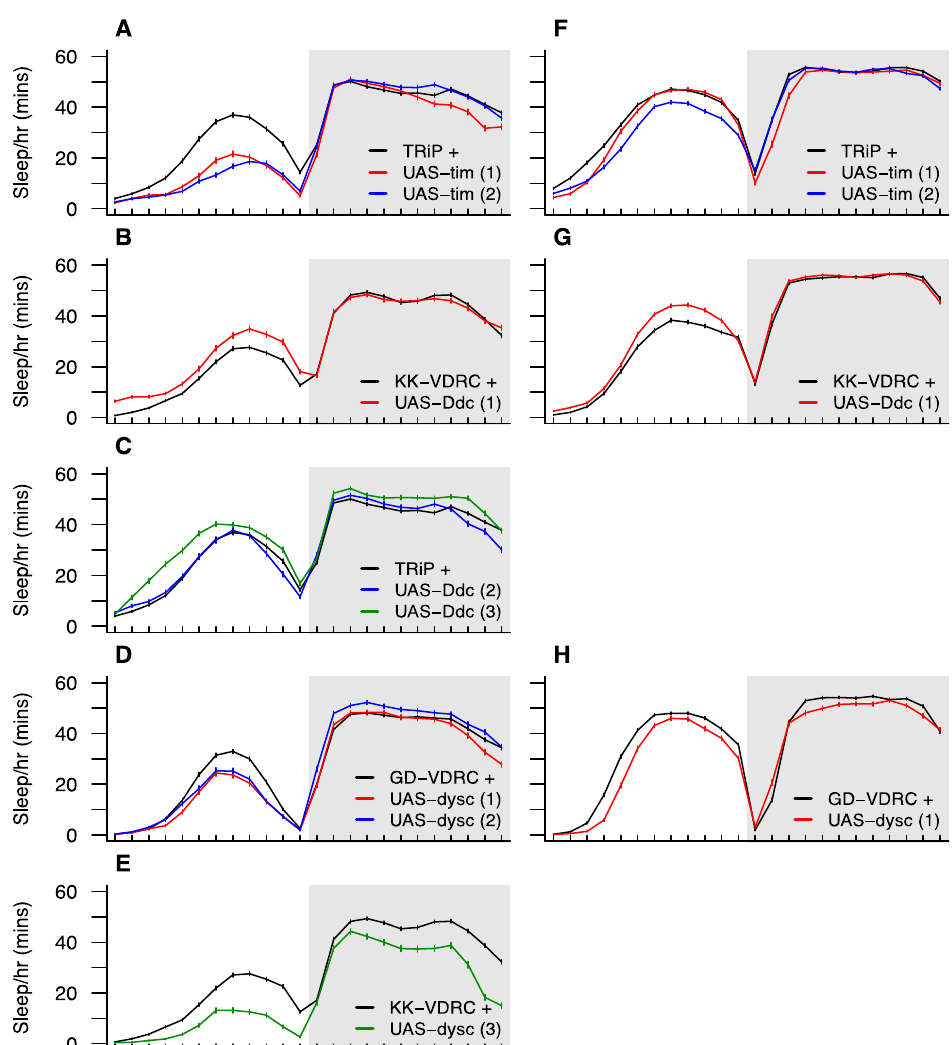
Figure 5. Sleep time profiles for RNAi knockdown of candidate genes. We tested three candidates, each residing under a different QTL group: timeless (QG2), Dopa decarboxylase (QG6), and dyschronic (QG10). For each gene, we tested multiple UAS-RNAi transgenes (shown in red, blue, and green lines) against the appropriate control strain (shown in black). Panels A – E show results of RNAi driven using the pan-neuronal elav -Gal4 driver, and panels F – H show the results of RNAi for a subset of the strains driven by elav -GeneSwitch-Gal4 specifically in adult neurons using the RU486-inducible system. In the figure, simple codes are provided to describe transgenes and controls. Stock numbers for these are: TRiP + (BDSC 35788), UAS-tim #1 and #2 (29583 and 40864), UAS-Ddc #2 and #3 (27030 and 51462), KK-VDRC + (VDRC 60100), UAS-Ddc #1 (109881), UAS-dysc #3 (11019), GD-VDRC + (60000), and UAS-dysc #1 and #2 (14082 and 28945). More detail is provided in Supplementary Table S12.